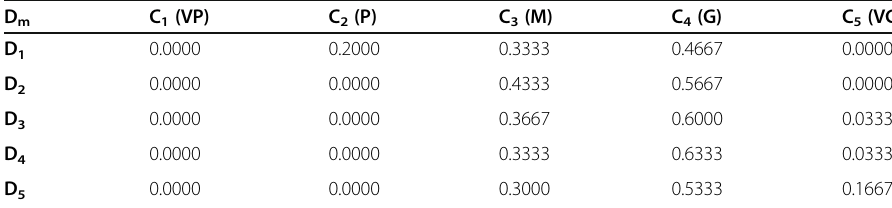
Table 3 Overall decision matrix